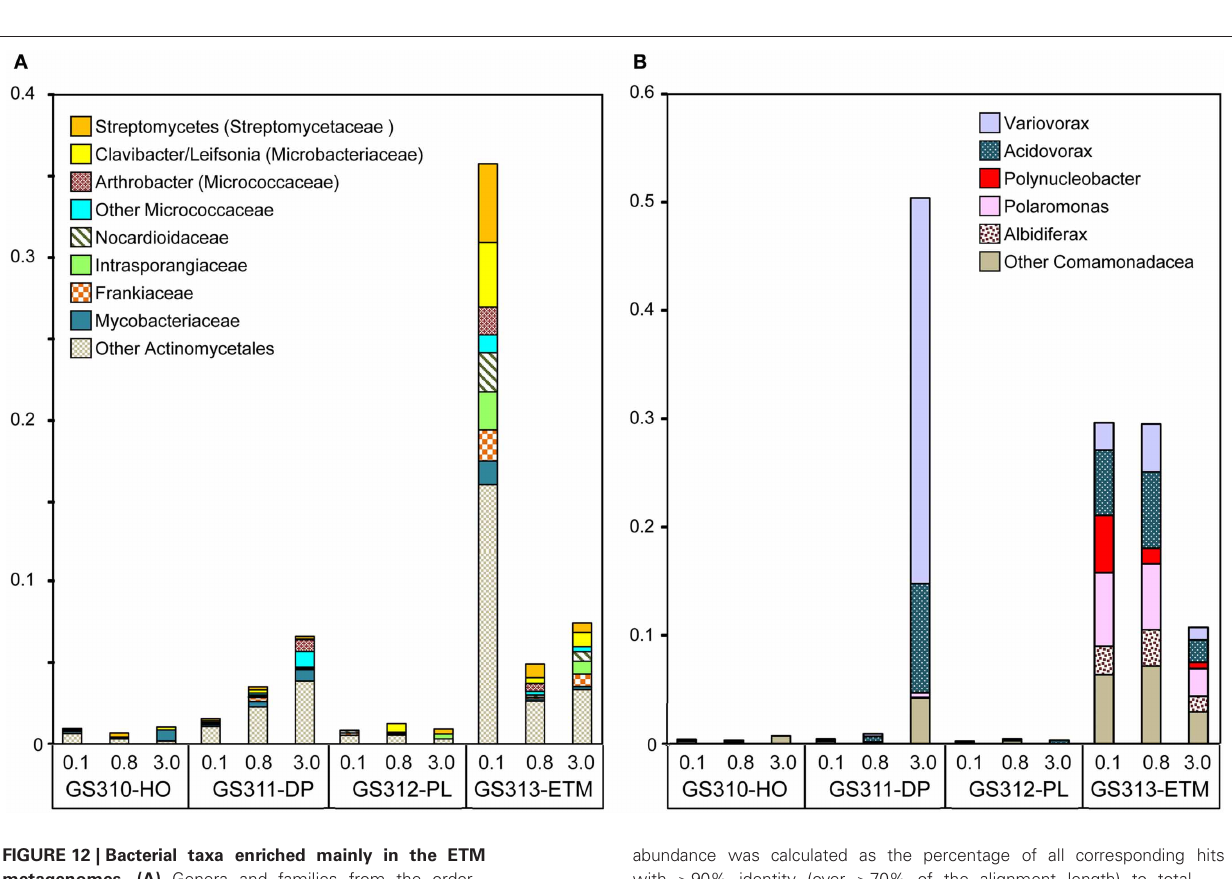
FIGURE 12 | Bacterial taxa enriched mainly in the ETM metagenomes. (A) Genera and families from the order Actinomycetales (Actinobacteria). (B) Genera from families Burkholderiaceae and Comamonadaceae (Betaproteobacteria). Taxon